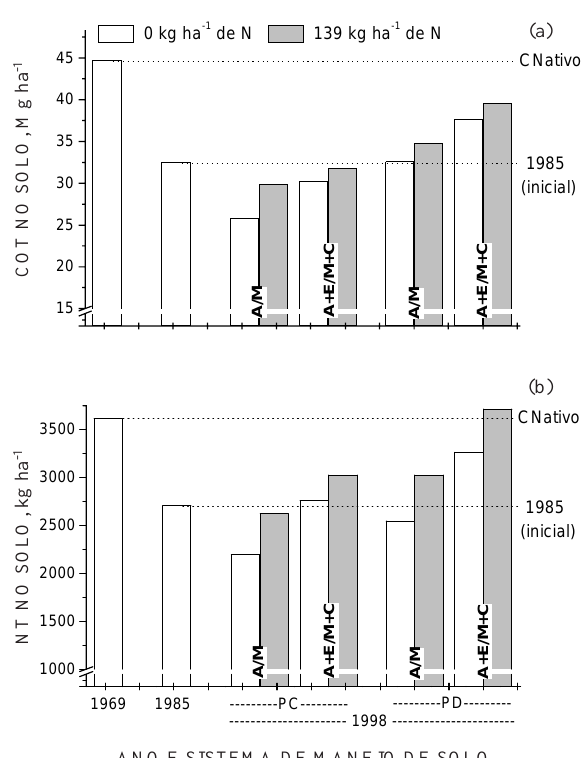
Figura 3. Estoques de carbono orgânico total-COT (a) e de nitrogênio total-NT (b) no solo (0-0,175 m) sob campo nativo (1969), referência da condição original do solo, por ocasião do início do experimento (1985), e após 13 anos (1998) da utilização dos sistemas de preparo convencional (PC) e plantio direto (PD) nos sistemas de culturas aveia/milho-A/M e aveia + ervilhaca/milho + caupi-A + E/M +